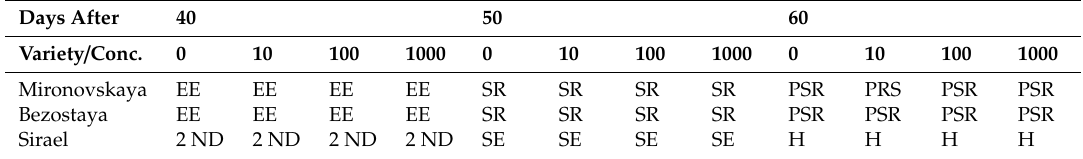
Table 1. Overview of developmental stages of wheat varieties at 40, 50 and 60 days of